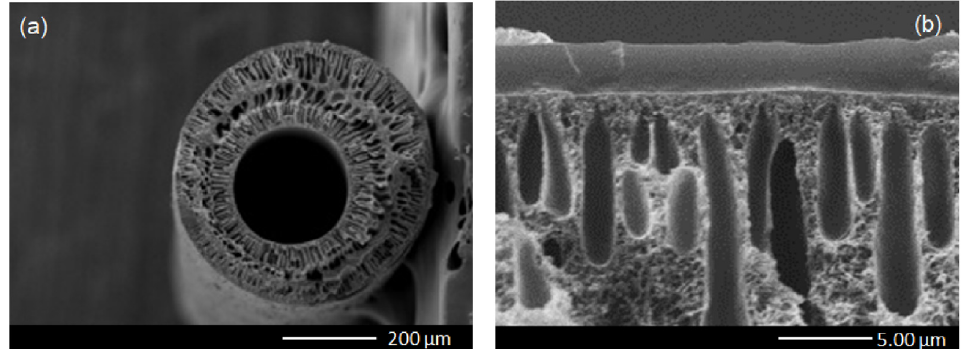
Figure 3. Cross-sectional view of ( a ) PSF hollow fiber support, and ( b ) PSF hollow fiber support coated with Pebax.